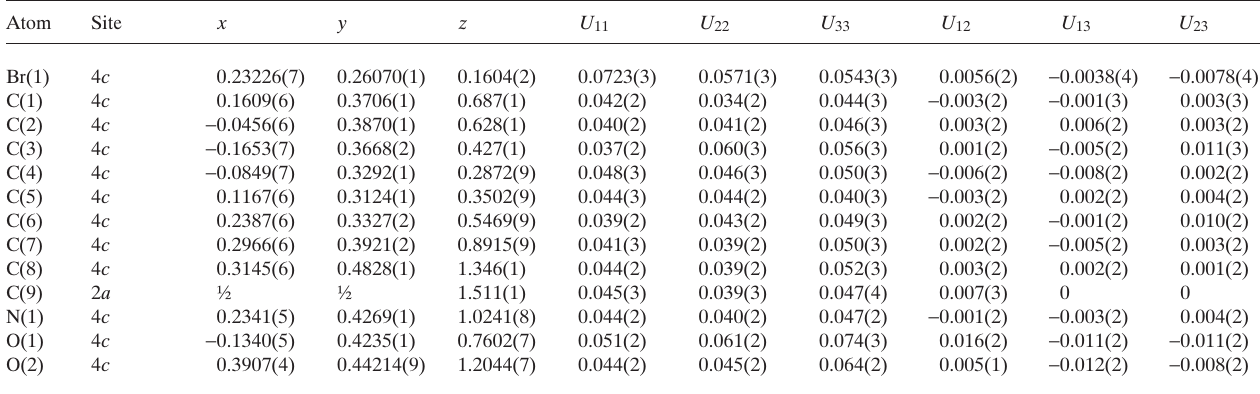
Table 3. Atomic coordinates and displacement parameters (in Å 2 ) .